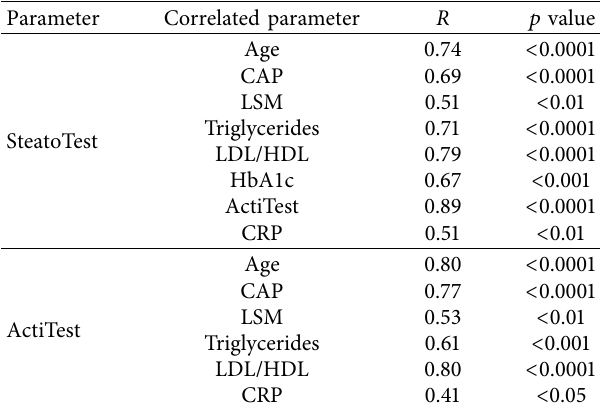
Table 3: Correlation of SteatoTest and